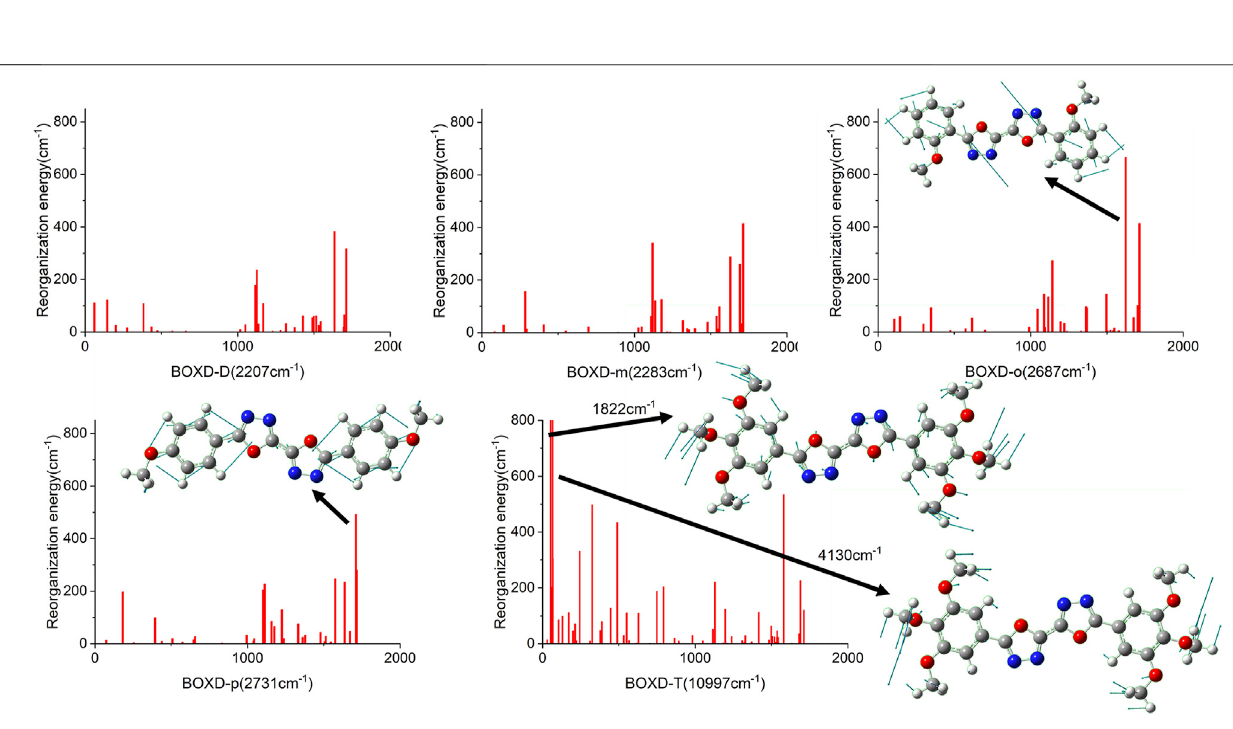
Frontiers in Chemistry |